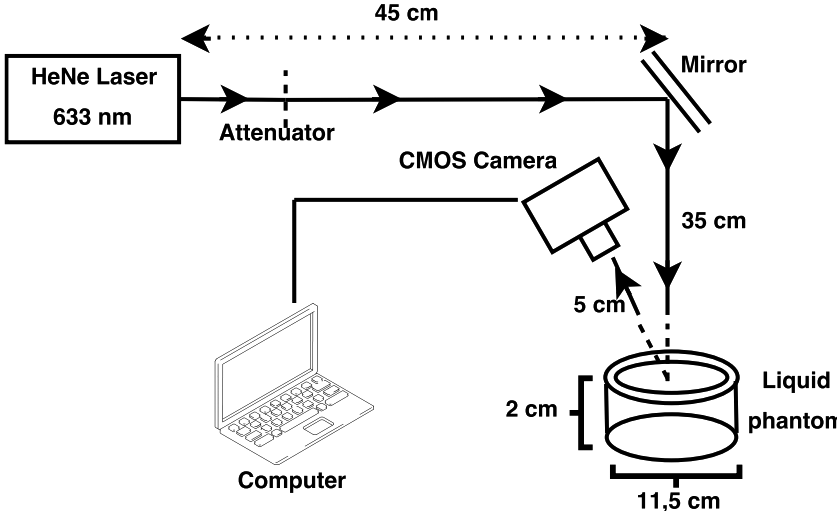
Fig. 2. Di®use re°ectance-based experimental setup for surface imaging of the phantoms.